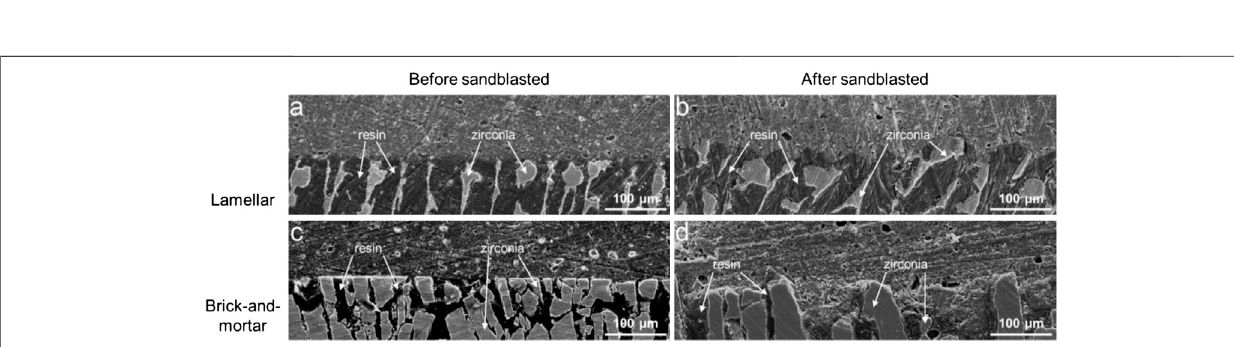
Frontiers in Bioengineering and Biotechnology |